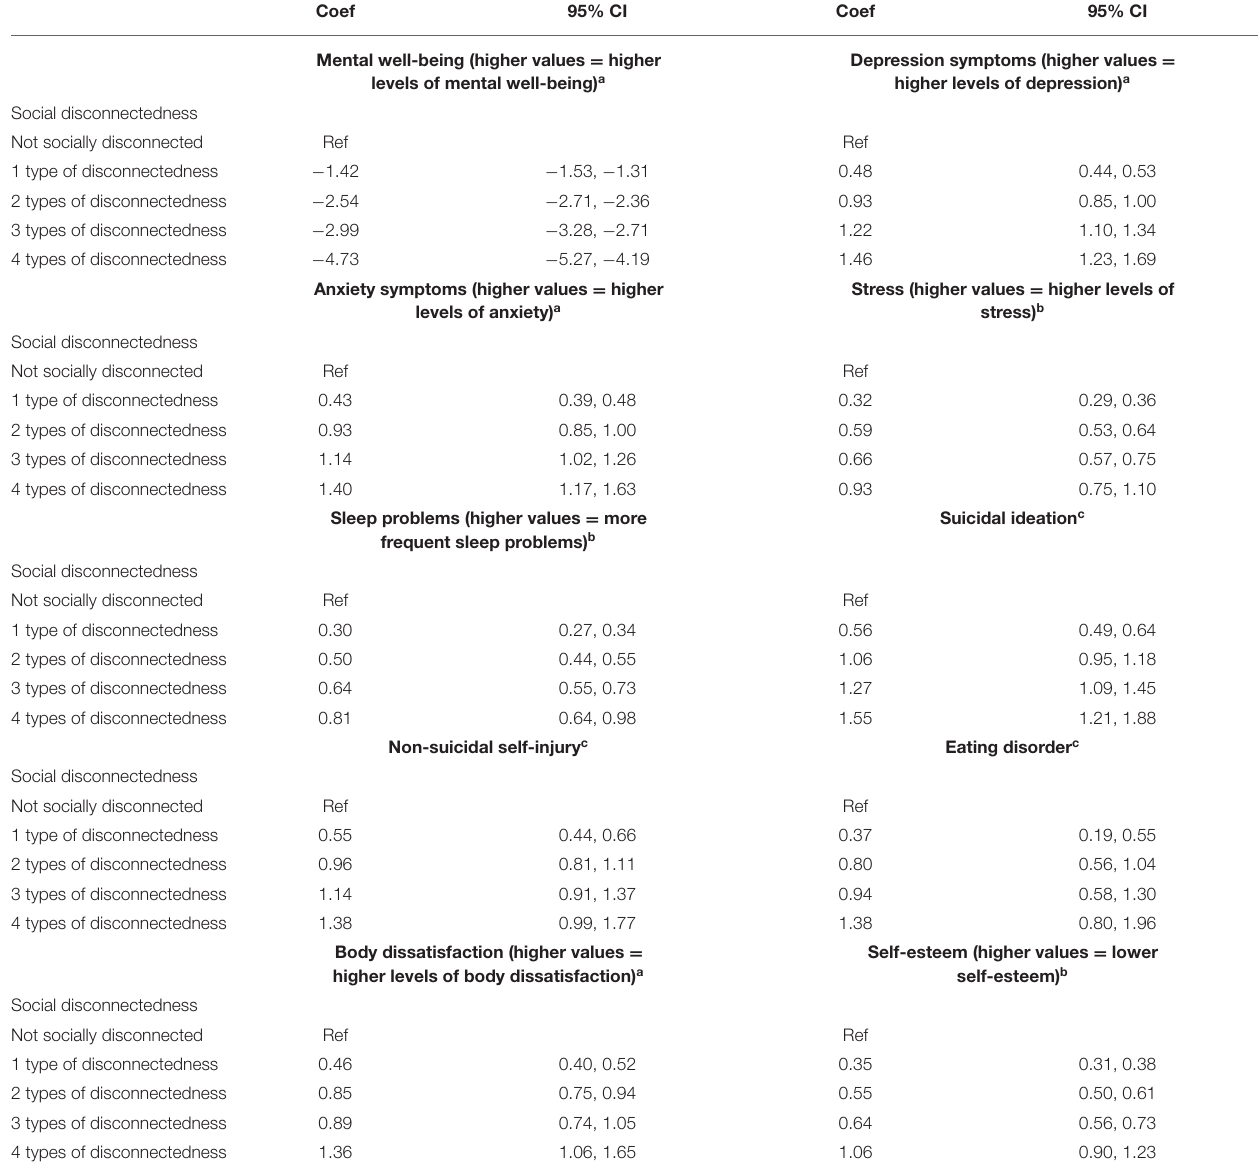
TABLE 3 | Regression analyses predicting mental health outcomes by social disconnectedness in school (categorical